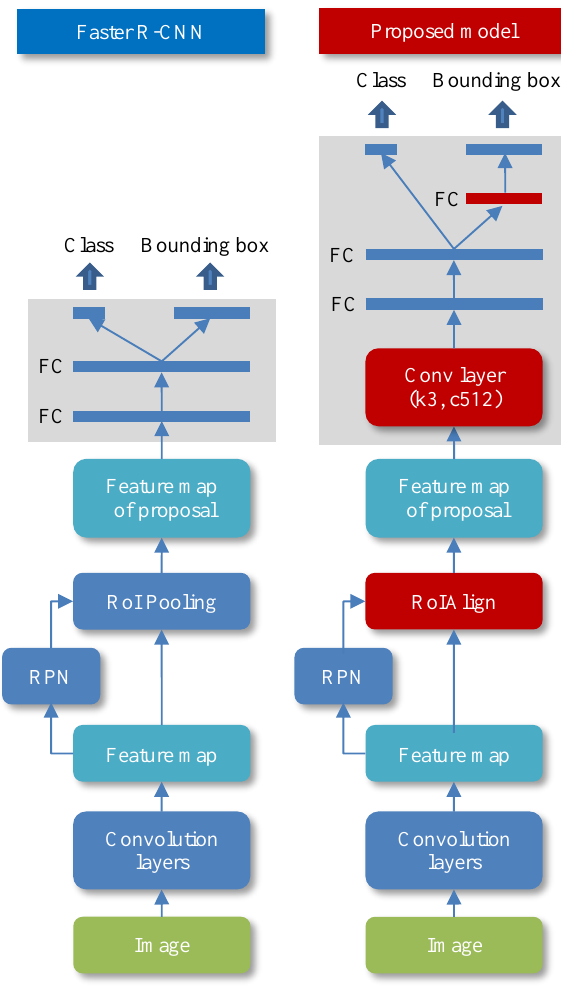
Figure 4. Faster R-CNN and proposed